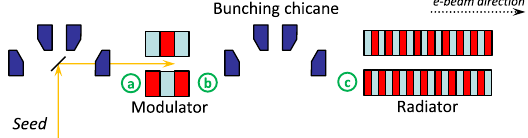
FIG. 1. Layout for the HGHG setup. The electron beam is energy-modulated by an external laser at long wavelength λ the modulator. After converting the energy modulation into a density modulation in the bunching chicane, the electron beam radiates at a harmonic wavelength λ n ¼ λ wavelength in the radiator, which is typically tuned between n ¼ 5 and n ¼ 12 .